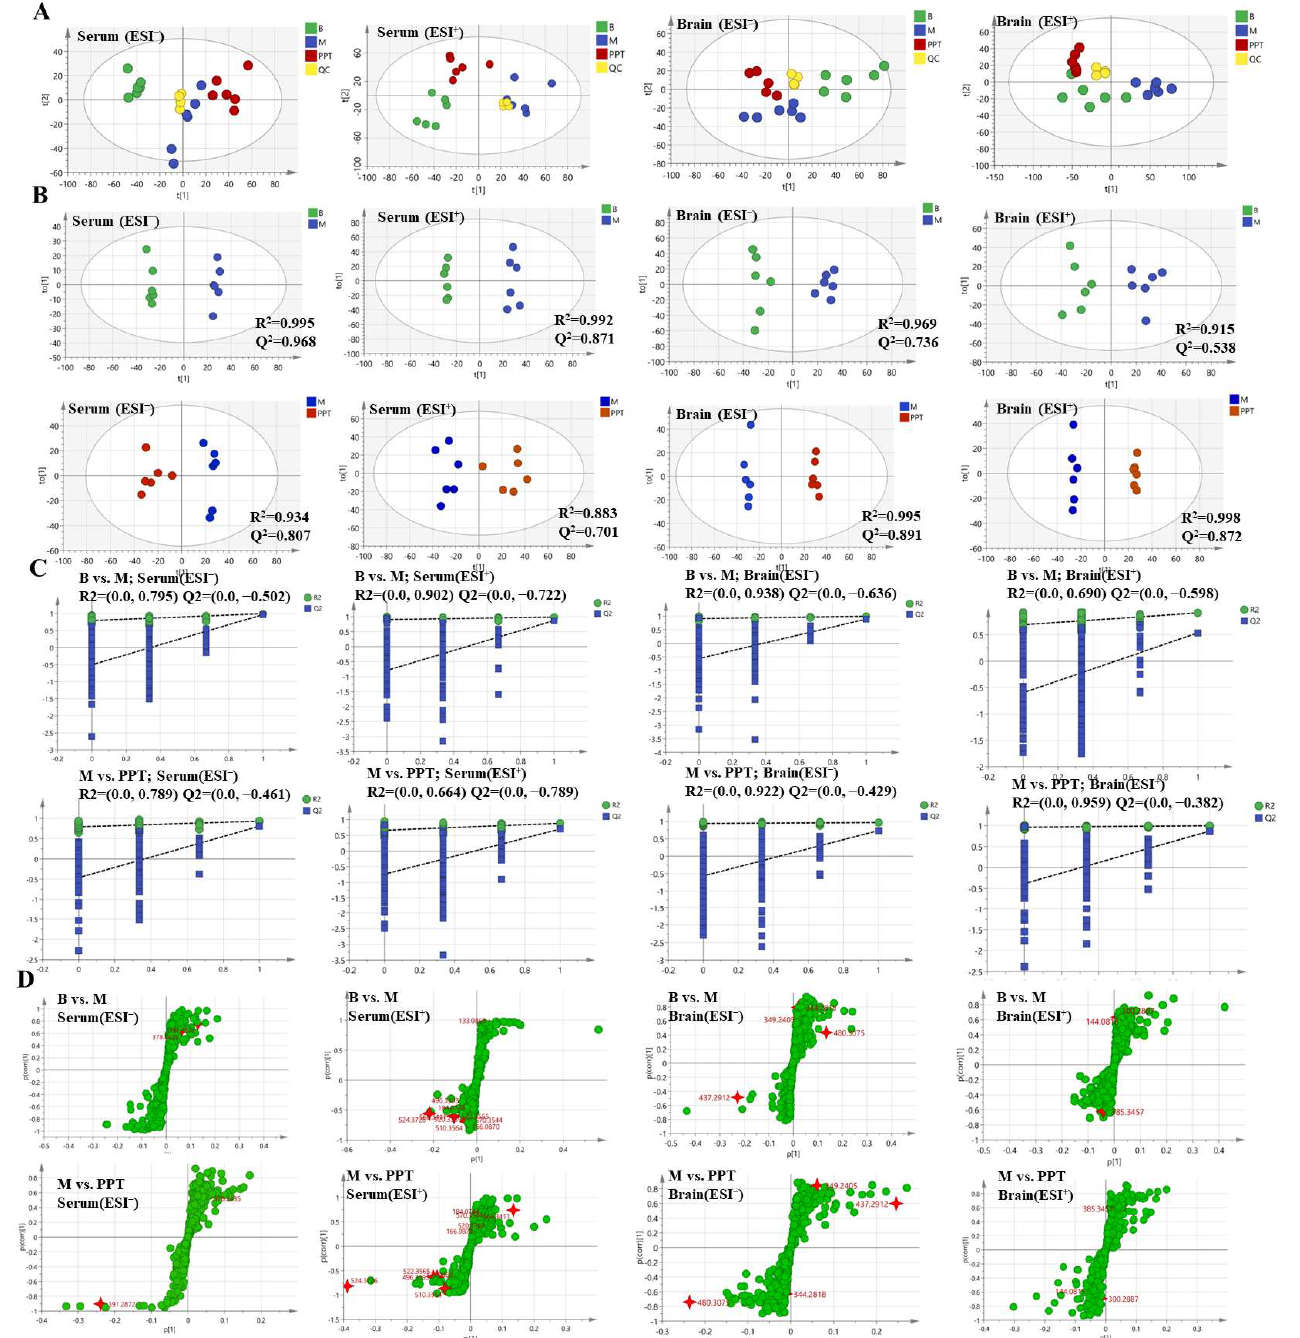
Figure 6. The metabolic profile of serum and brain are shown in PCA score ( A ), OPLS-DA score ( B ), permutations test plots ( C ), and OPLS-DA S-plots ( D ). “B” represents sham group; “M” represents model group.